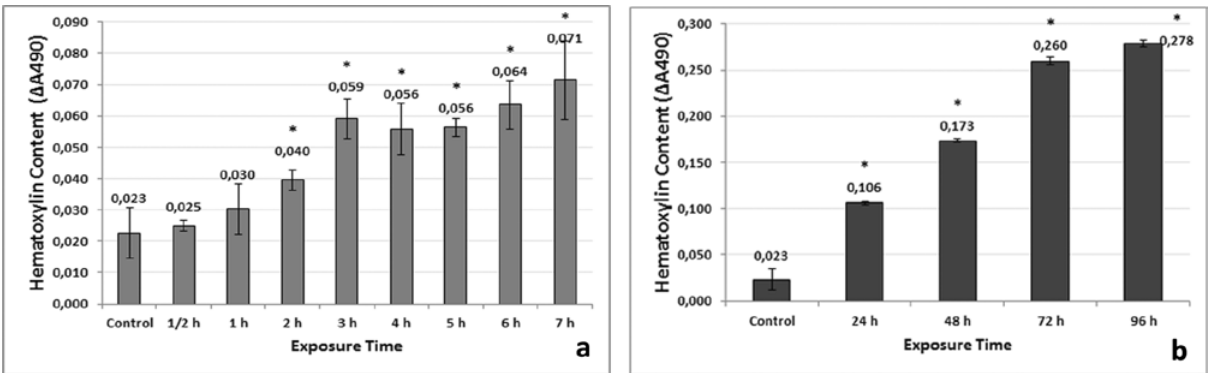
Figure 1. Hematoxylin content of control and 100 µM AlCl 3 treated barley roots at short (a) and long (b) time points. The data with (*) are significantly different from the control at P < 0.05 level.